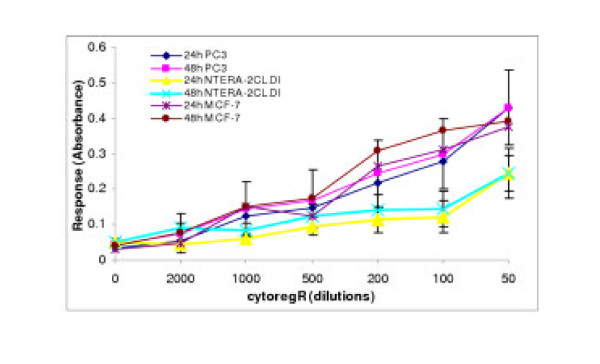
Growth inhibition of human adenocarcinoma cells exposed to cytoregR. Cells were grown and treated with indicate concentrations/dilutions of cytoregR as described in themethods. Treatment-induced cytotoxicity was assessed by measuring the release of lactate dehydrogenase from dead cells, using the LDH assay as described in the methods. The values/data points represent the means ± SEM of triplicates from two independent experiments